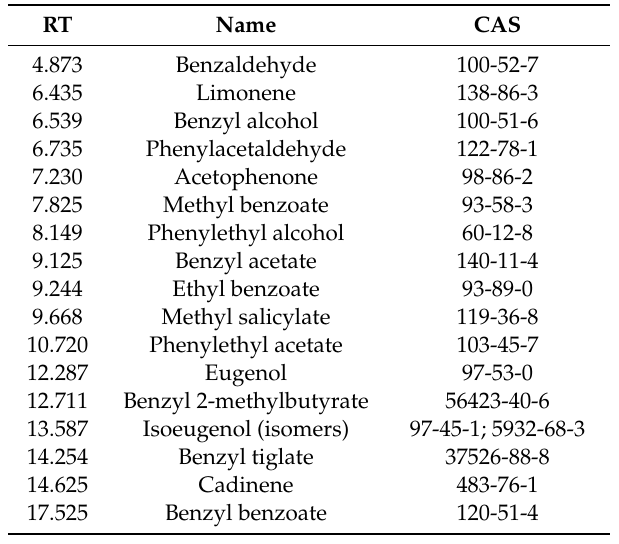
Table 3. Retention time (RT) expressed in minutes, name and CAS number (assigned by the Chemical Abstract Services) of selected